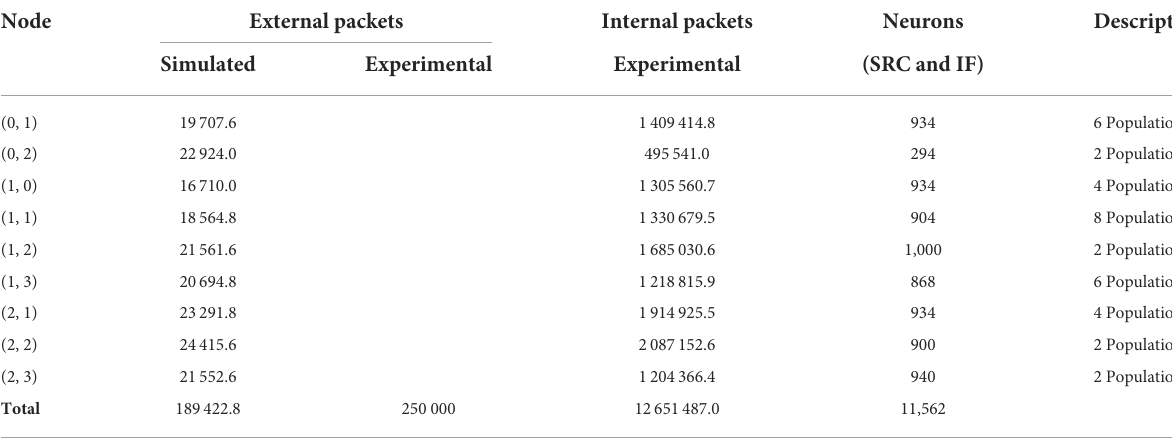
TABLE 4 Simulated communication traffic results for the test case mapped with the GHOST procedure.